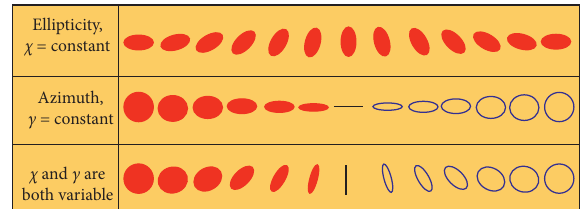
Figure 6: Polarization ellipses with different azimuths and/or